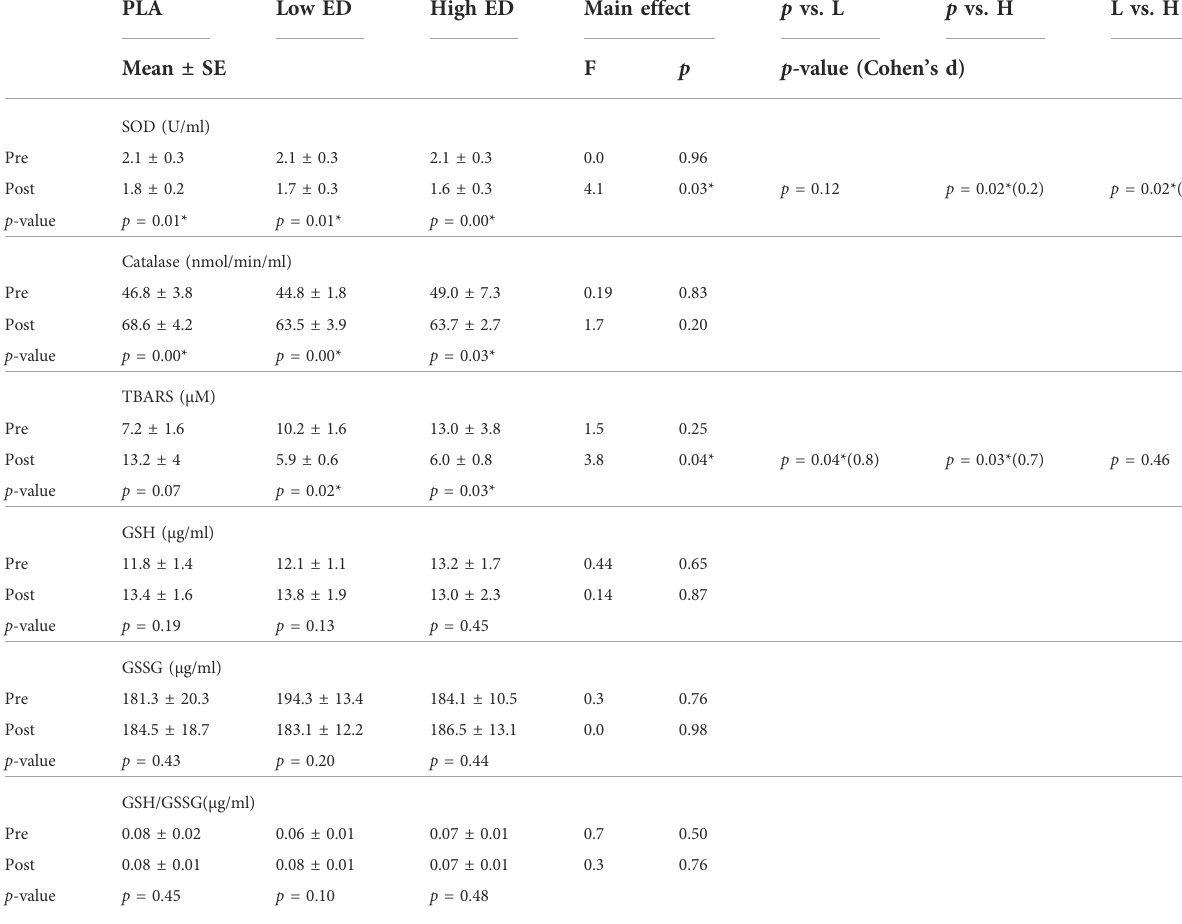
TABLE 2 Oxidation stress response with placebo (PLA), low-dosage caffeinated energy drink (Low ED) group and high-dosage caffeinated energy drink (High ED) group before and after participation in a sprint triathlon. *Signi fi cant difference at p < 0.05.